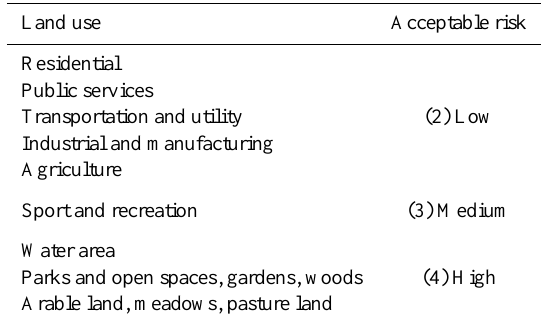
Table 2. An example of selected land use zones (MA CR,